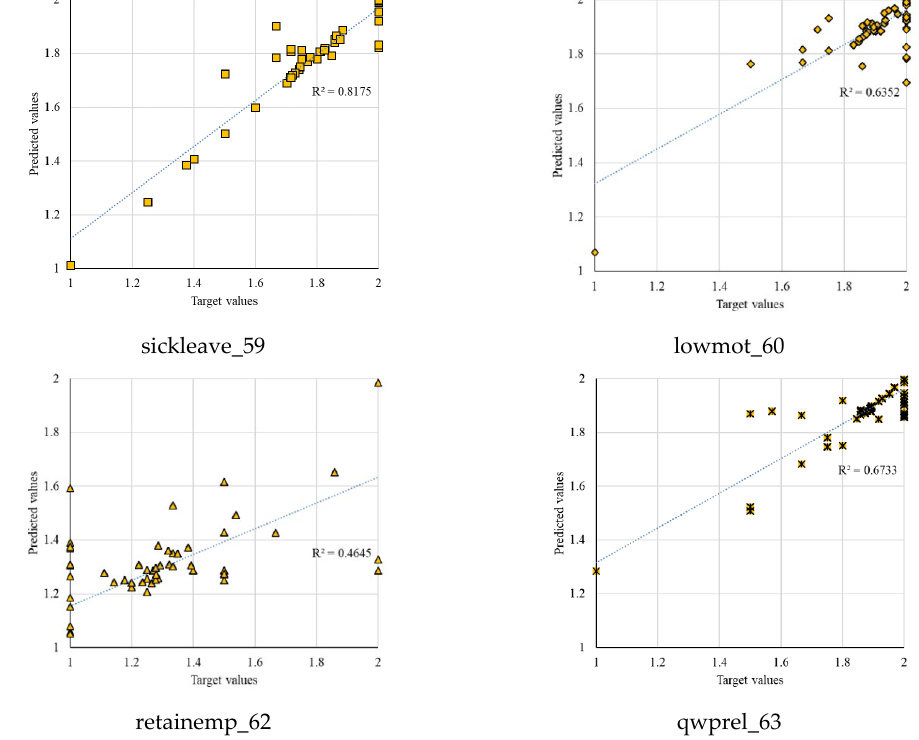
Figure 4. Plot diagrams for the effects of work organization on output values of employee wellbeing.